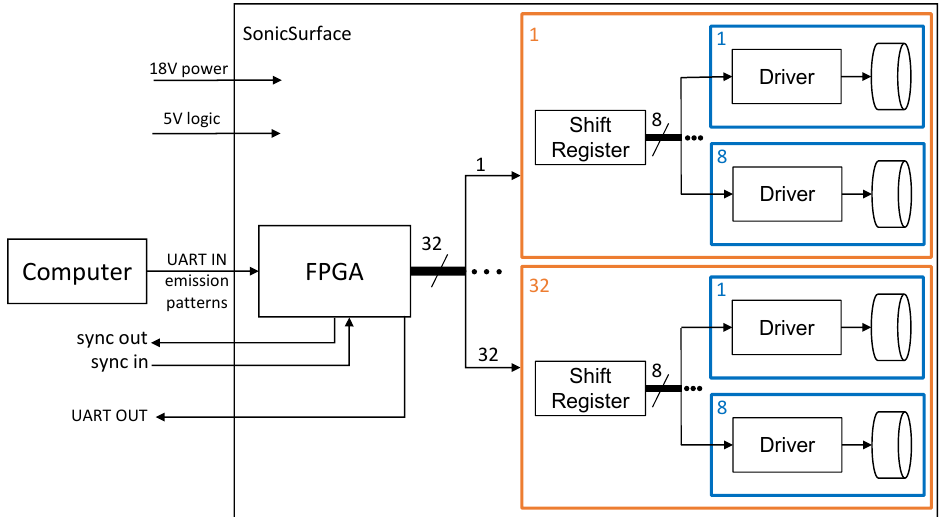
Figure 1. Schematic of the SonicSurface ultrasonic array. A field-programmable gate array (FPGA) receives the phases to be emitted from a computer, they are stored on a double buffer and constantly output. The FPGA multiplexes 8 channels into one line so that only 32 output pins are needed. There are 32 blocks of shift registers, being able to drive a total of 256 emitters.